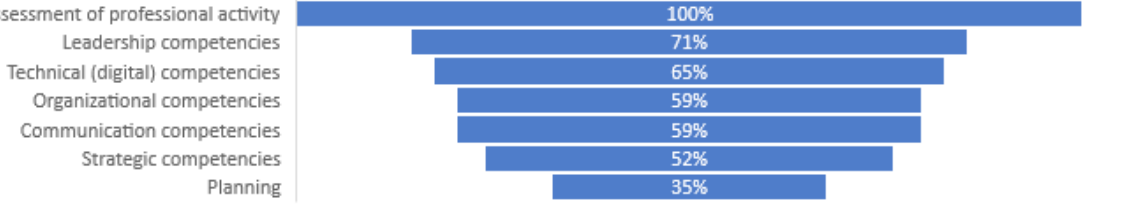
Figure 3. The frequency of demand for managerial competencies in the labor market of